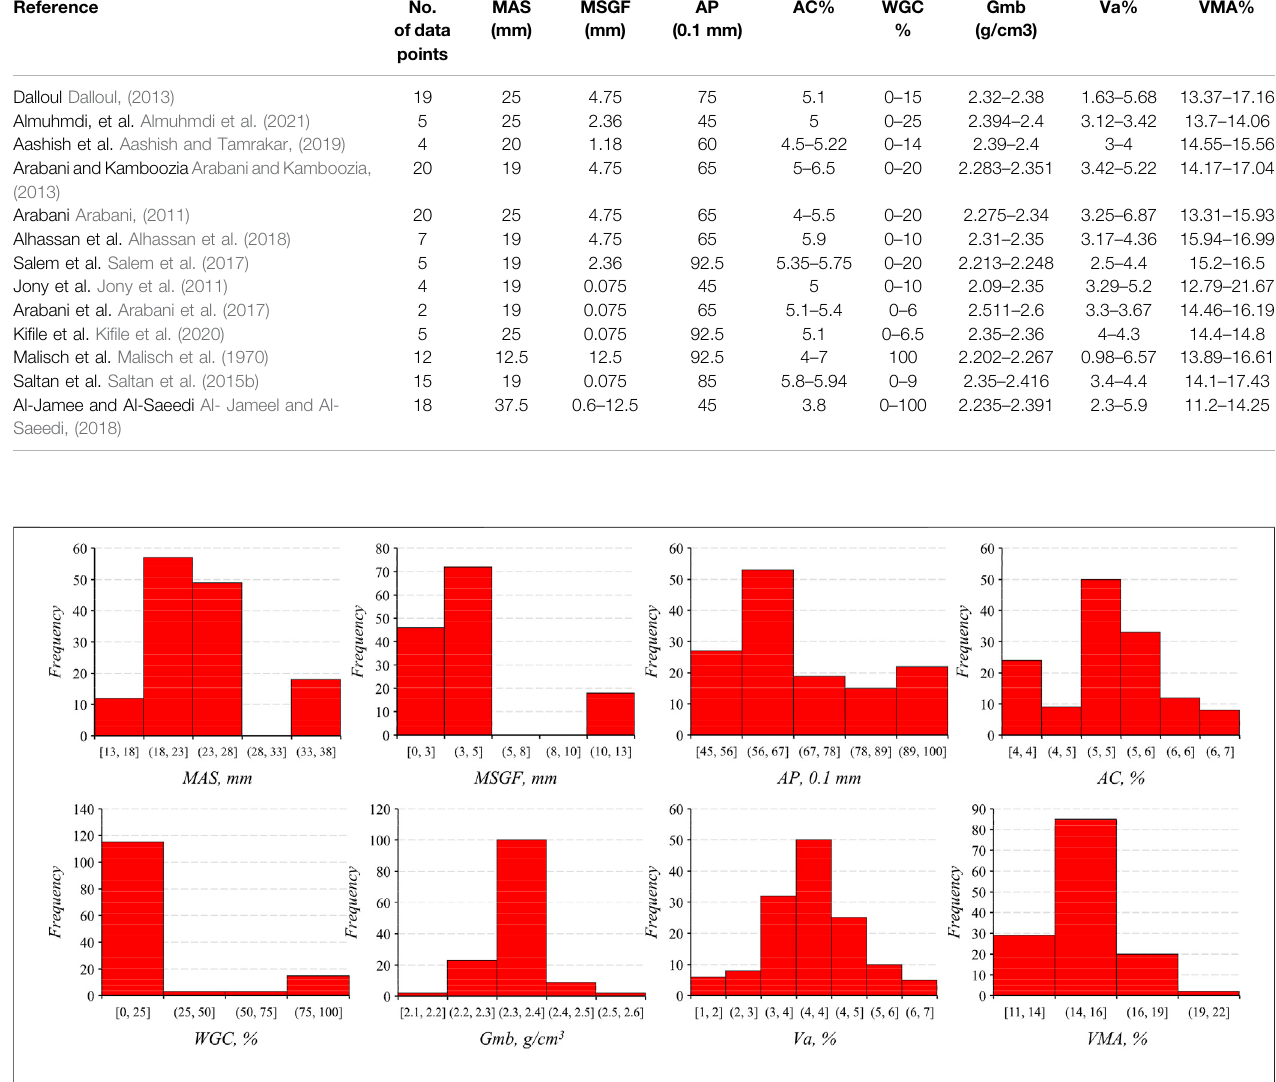
FIGURE 2 | Distribution of the selected variables used in the ANN